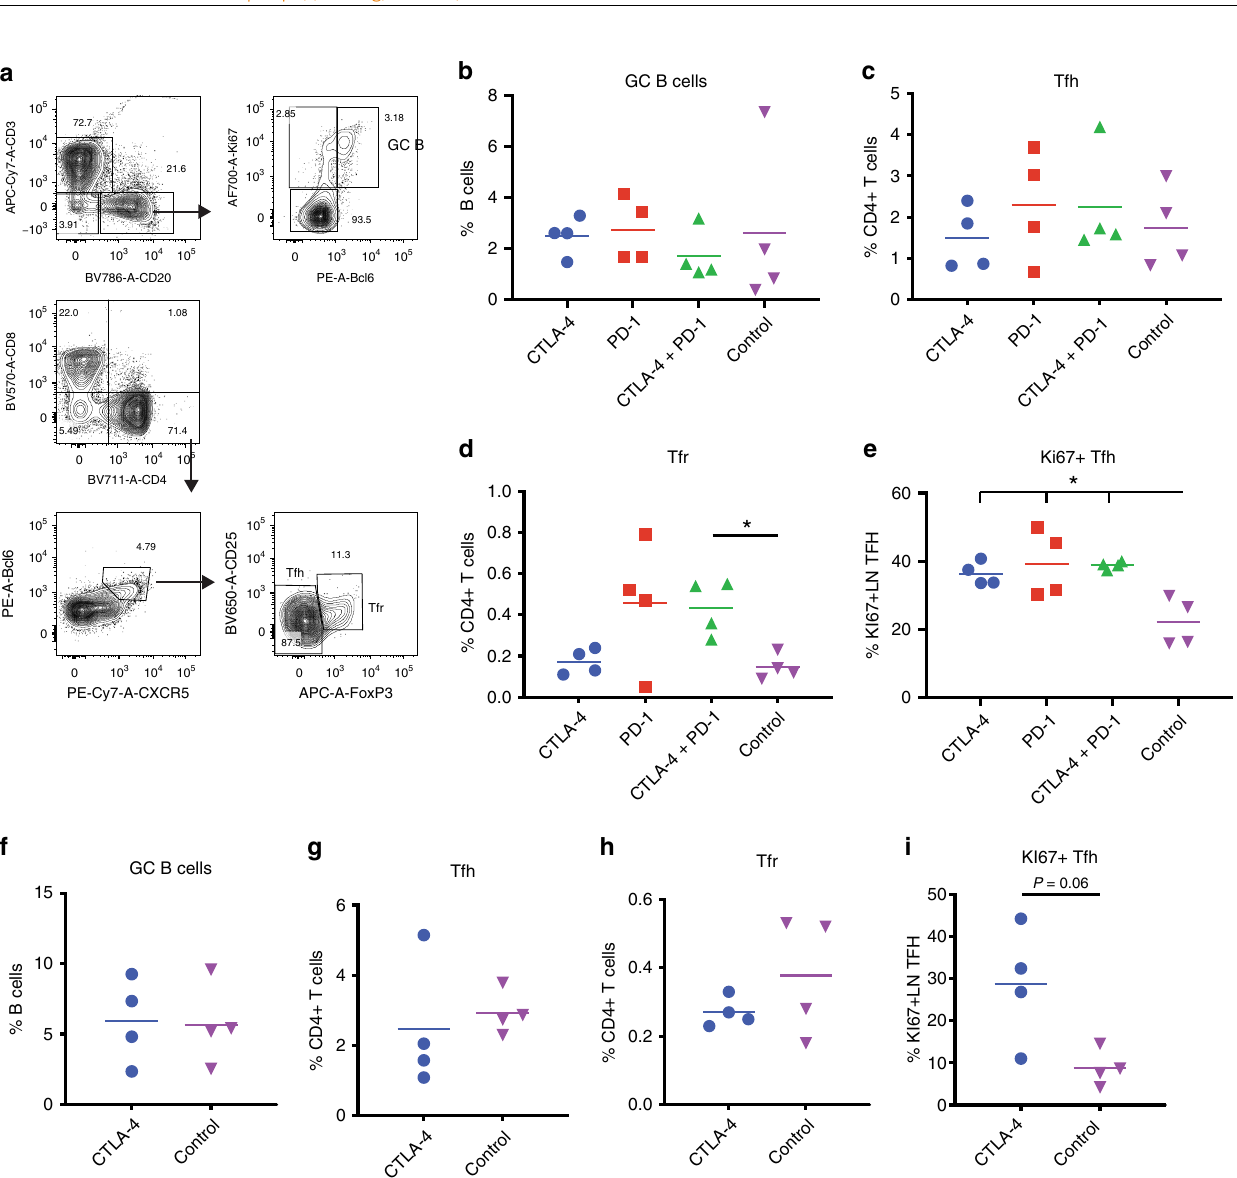
Fig. 4 Immune checkpoint blockade increases the number of activated T cells in lymph node. a Representative fl ow cytometry gating strategy to classify germinal center B cells, Tfh and Tfr cells in lymph node samples. b – e Percentage of ( b ) germinal center B cells ( c ) CD4 + T follicular helper cells ( d ) CD4 + T follicular regulatory cells in the axillary lymph node 1 week after the 2nd immunization and co-administration of checkpoint blockade antibody (week 5; NHP study #1). e Percentage of Ki67 + CD4 Tfh cells in each group. Points represent individual animals and color designates antibody treatment group (* P